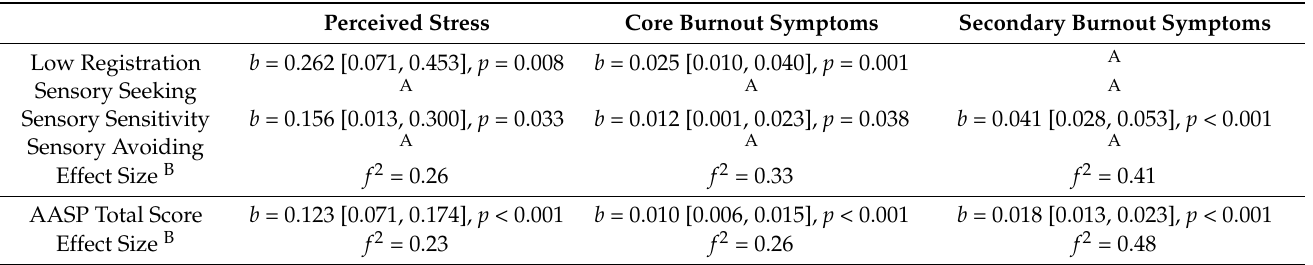
Table 3. Multiple regression models with AASP raw quadrant and total scores, and stress- and burnout-related total scores.